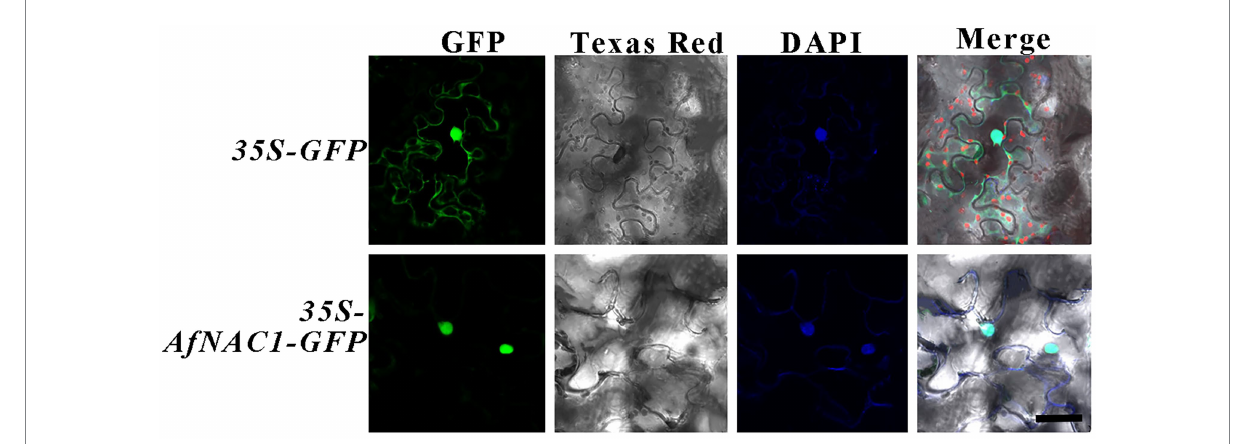
FIGURE 4 Subcellular localization of AfNAC1 protein in tobacco cells. Bar, 50 μ m.